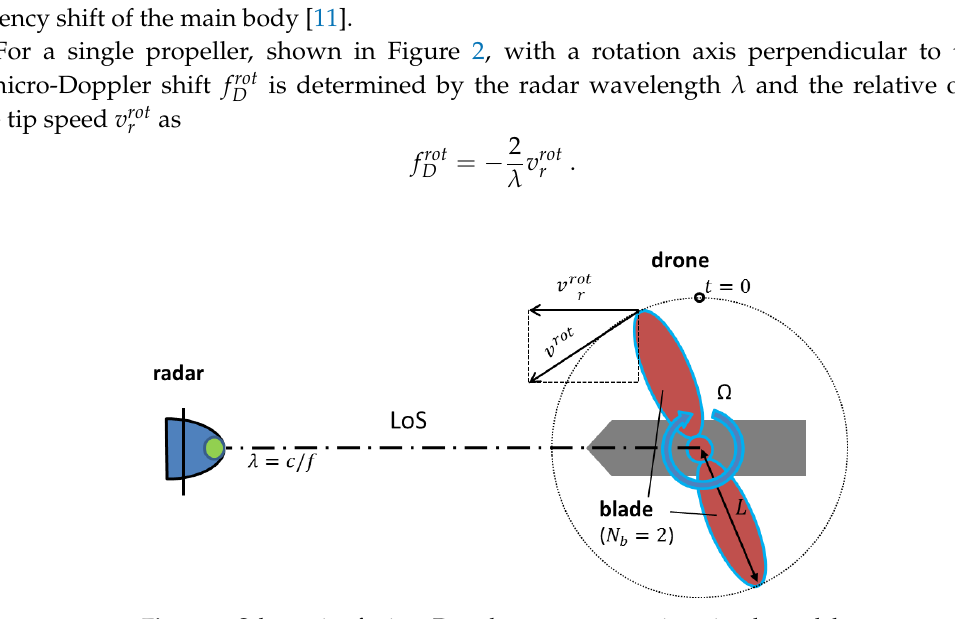
Figure 2. Schematic of micro-Doppler measurement in a simple